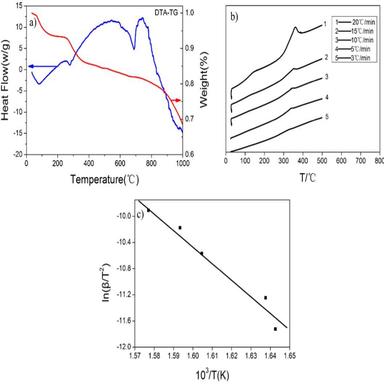
DTA-TG profile (a), DSC curve of the precursor at different heating rates (b) and the fitted line using the Kissinger method (c) of precursor and lithium carbonate.